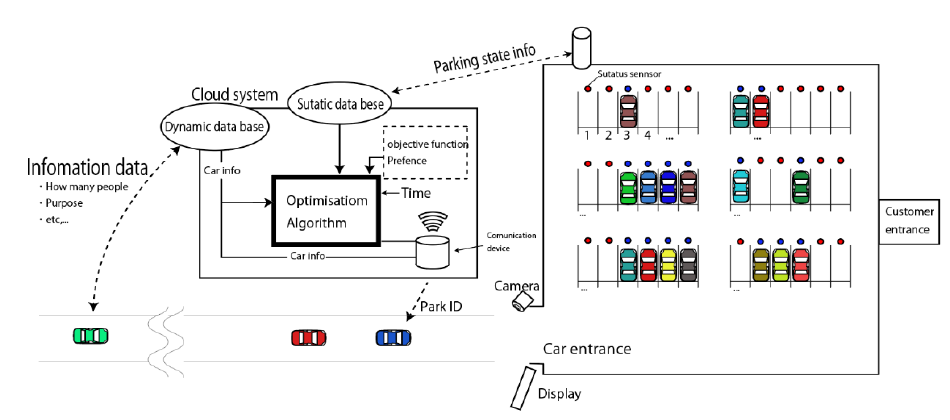
Figure 1: Concept and architecture of the proposed smart car parking management